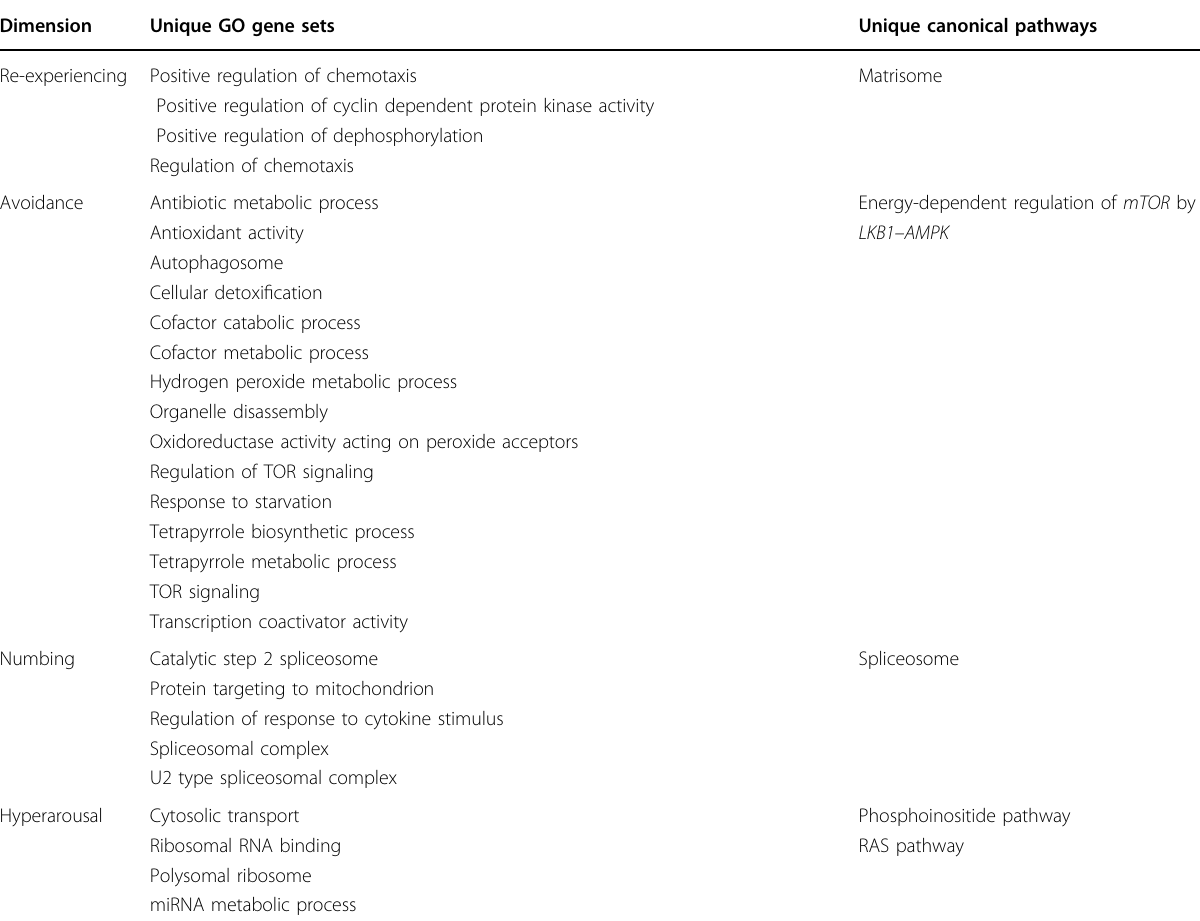
Table 2 List of GO and canonical pathway gene sets unique to each PCL dimension analysis. Dimension Unique GO gene sets Unique canonical